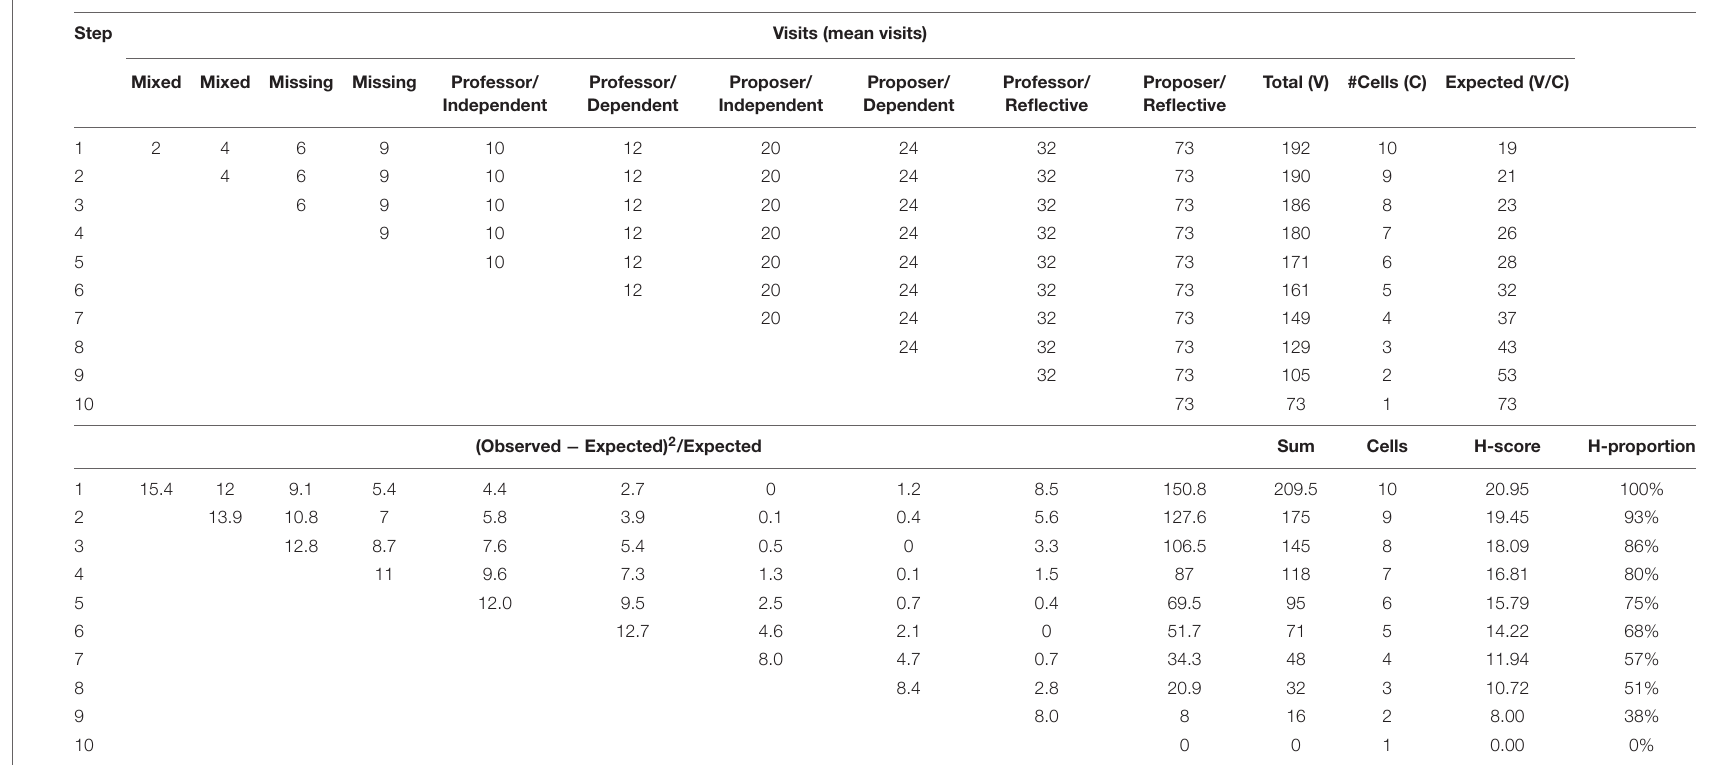
TABLE 6 | Derivation of attractors with heterogeneity score in a ten-used-cell (3 × 5) grid in level 2 change